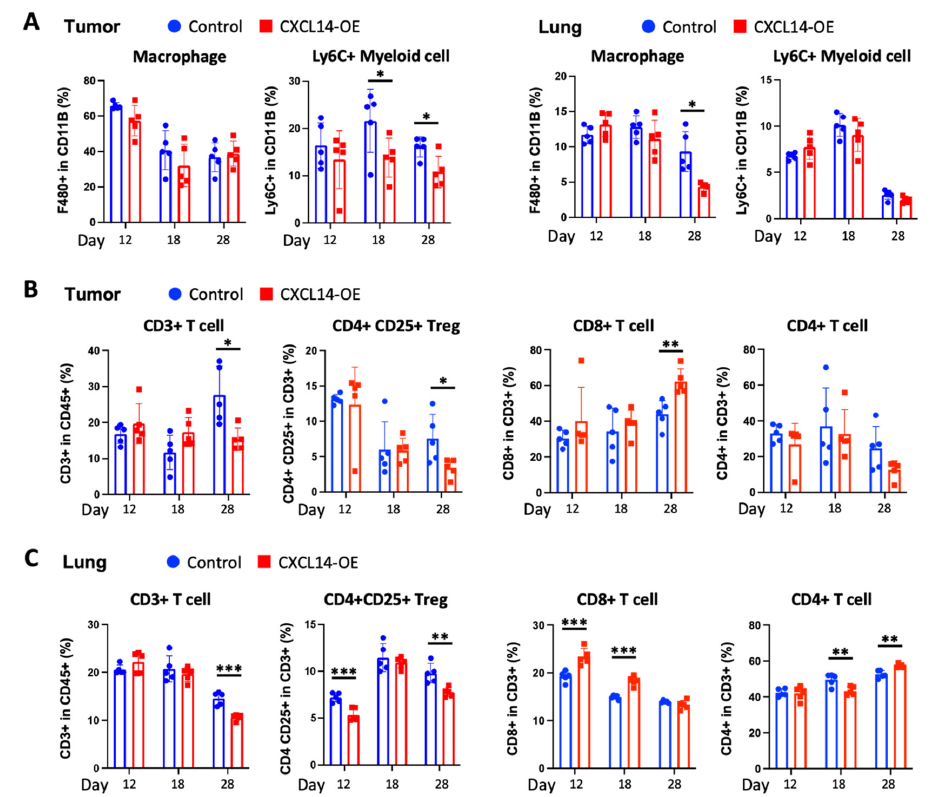
Figure 4. CXCL14-induced immune-cell profiles in the tumor microenvironment of primary tumors and lung metastatic sites. ( A ) FACS analysis of CXCL14-induced myeloid cell profiles in primary tumors and metastatic lungs at day 12, 18, and 28, after mammary fat pad injection of control and CXCL14-OE 4T1 cells ( n = 5). ( B , C ) FACS analysis of CXCL14-induced lymphoid cell profiles in primary tumors and metastatic lungs at day 12, 18, and 28, after mammary fat pad injection of control and CXCL14-OE 4T1 cells ( n = 5). Data are presented as mean ± SD. * p < 0.05, ** p < 0.01, *** p < 0.001.